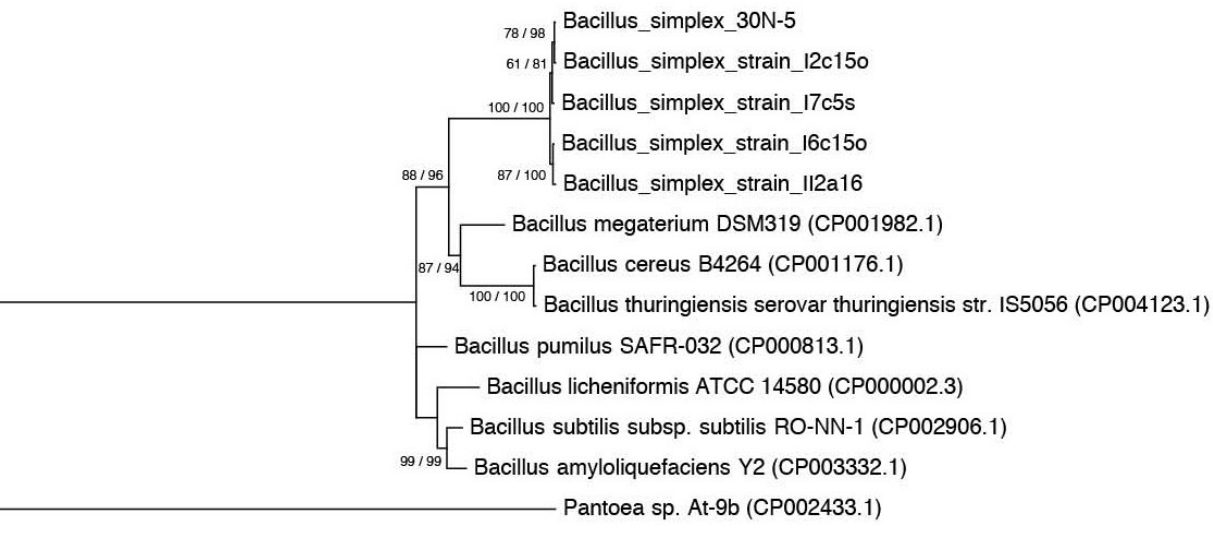
Figure 1. Multilocus sequence analysis of closely related members of the genus Bacillus and position of B. simplex 30N-5 within the B. simplex clade based on a concatenated set of four protein-coding genes ( gap A, rpo B, uvr A, pgk ). The bootstraps reported are listed in the order Maximum Likelihood/Neighbor Joining. Also, the values are only reported if both methods support the clade with a >50% bootstrap